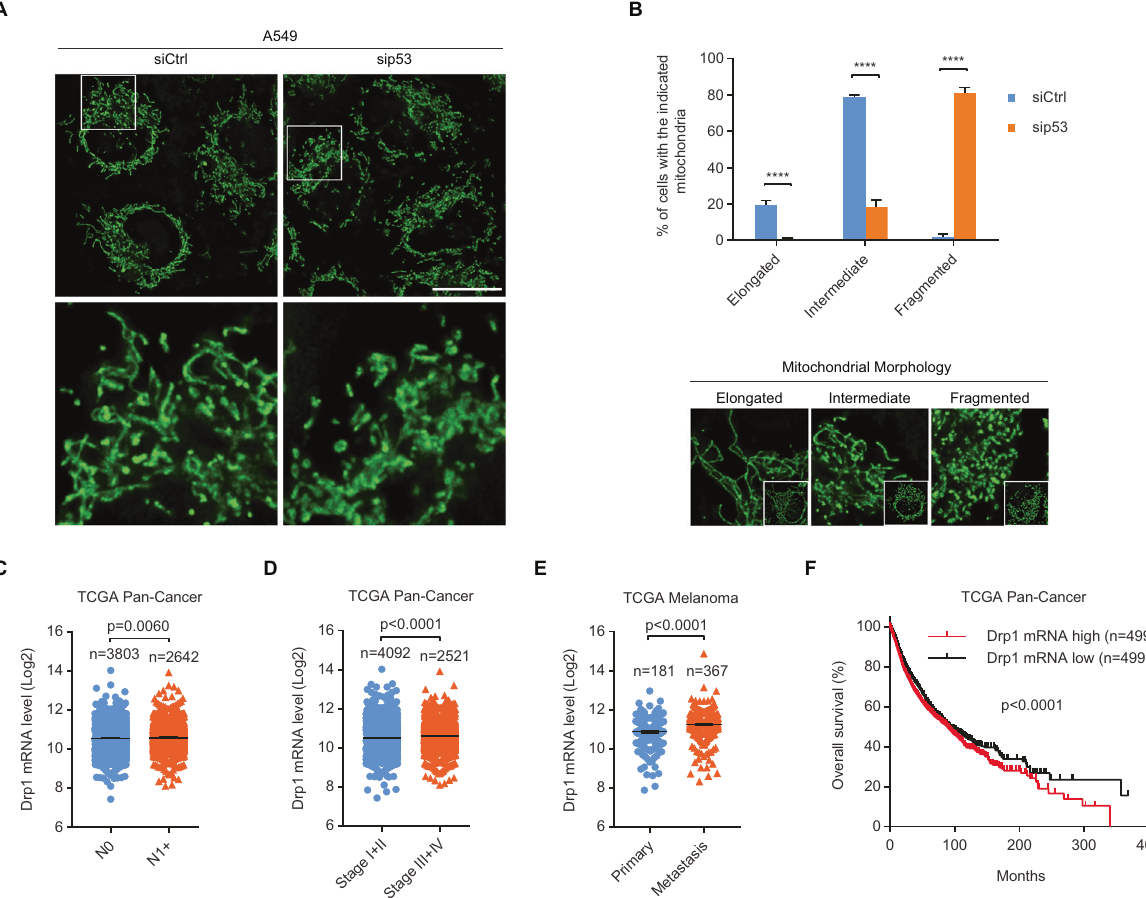
Fig. 2 p53 silencing ampli fi es mitochondrial fi ssion has diagnostic and clinical implications. Representative images ( A ) and quanti fi cation ( B ) of mitochondrial morphology in siCtrl ( n = 222) and sip53 ( n = 230) A549 cells. Boxed regions in ( A ) are shown enlarged in the bottom panels. Scale bar: 20 µm. B Representative images for each mitochondrial morphology type are shown in the bottom panels. Drp1 mRNA expression in ( C ) N0 and N1 + or ( D ) stage I + II and III + IV tumors. E Drp1 mRNA levels in primary and distant metastatic melanoma. F Kaplan – Meier analysis of overall survival in cancer patients with low and high Drp1 mRNA levels. Data were extracted from TCGA ( C – F ). Error bars represent mean ± SD ( B ) or SEM ( C – E ). Data were analyzed by one-way ANOVA with Tukey ’ s multiple comparisons test ( B ), two-tailed unpaired Student ’ s t test ( C – E ), or log-rank test ( F ). ****p <